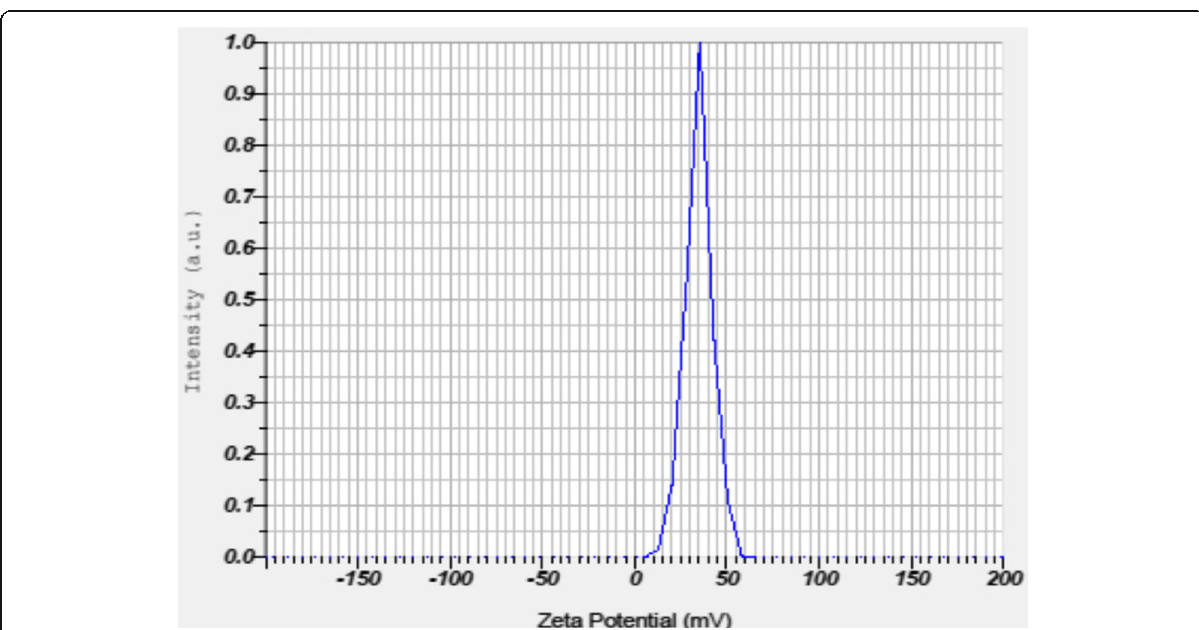
Fig. 4 Zeta potential analysis. Zeta potential (mean): − 30.9 mV. Zeta potential (mean): − 32.9 mV. Zeta potential (mean): − 34.9 mV